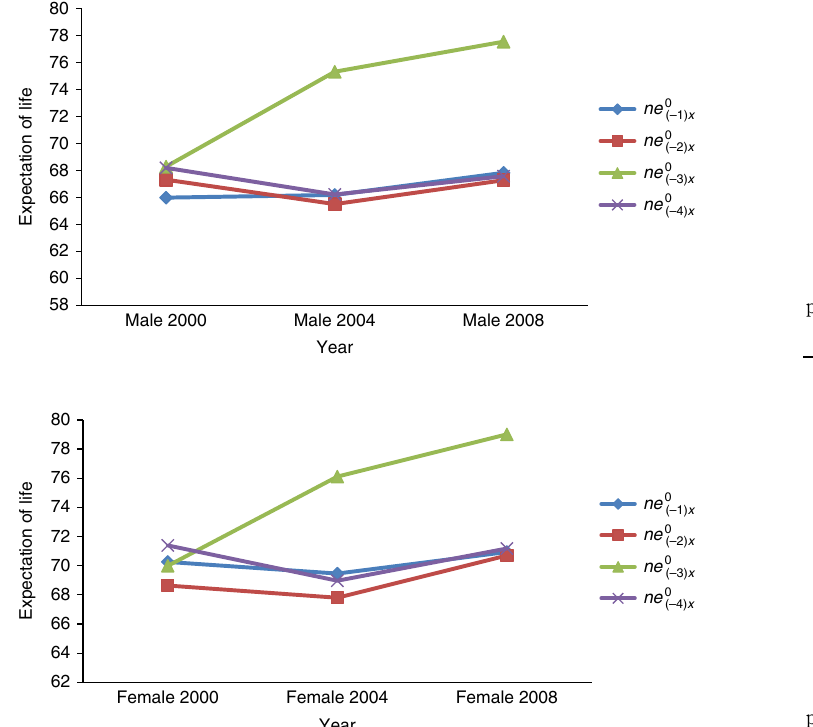
Figure 1. Life expectancy in specified causes of deaths ( D α ) eliminating the effect of a single cause of